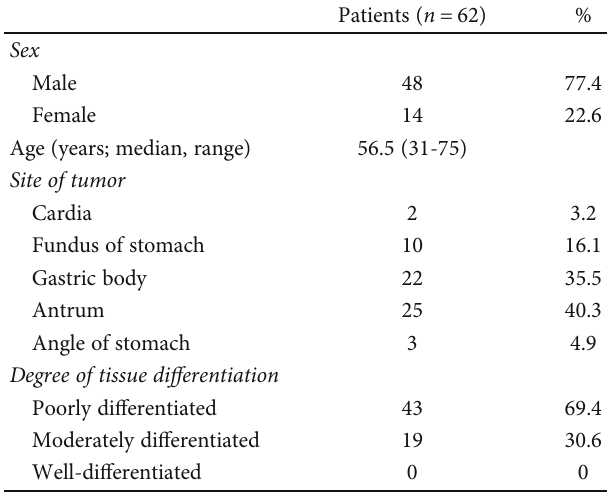
Table 1: Basic characteristic of 62